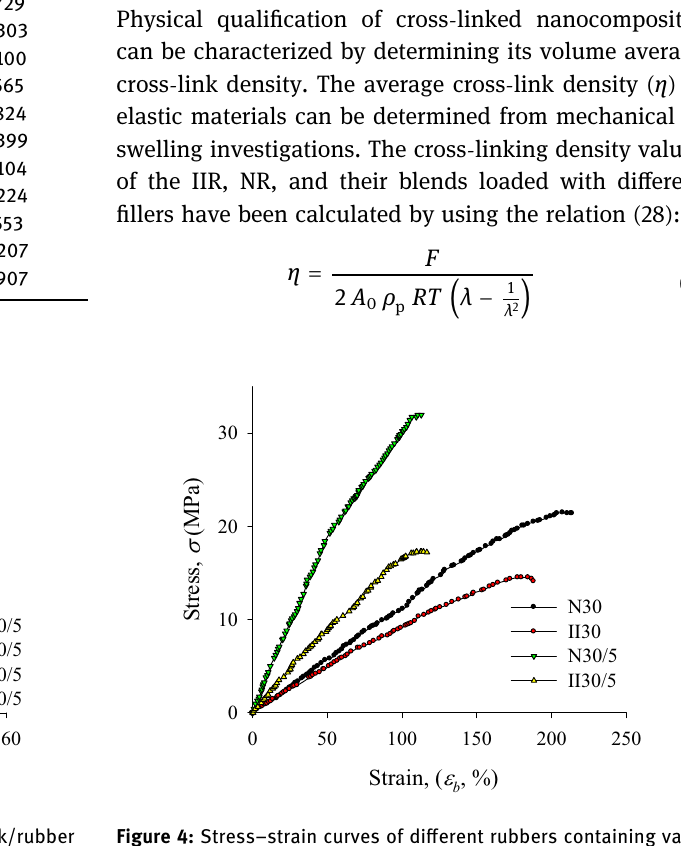
Figure 3: Stress – strain curves of TCNP - fi lled carbon black/rubber composites.